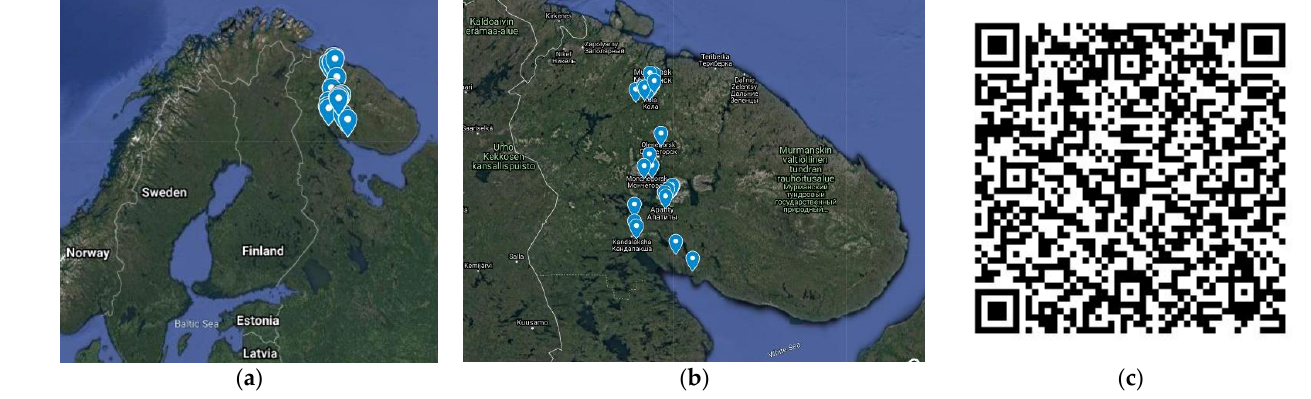
Figure 1. ( a , b ) Sampling points within the Murmansk region, Russia; ( c ) QR code for access to google map with marked selection points.